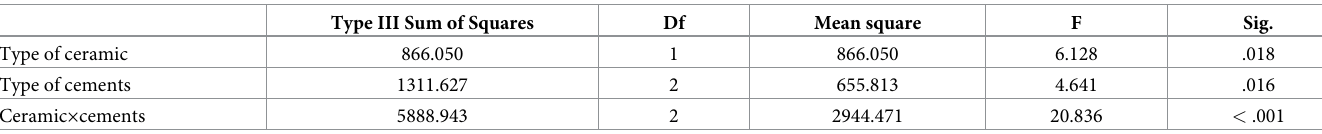
Table 4. Two-way ANOVA results for retentive strength